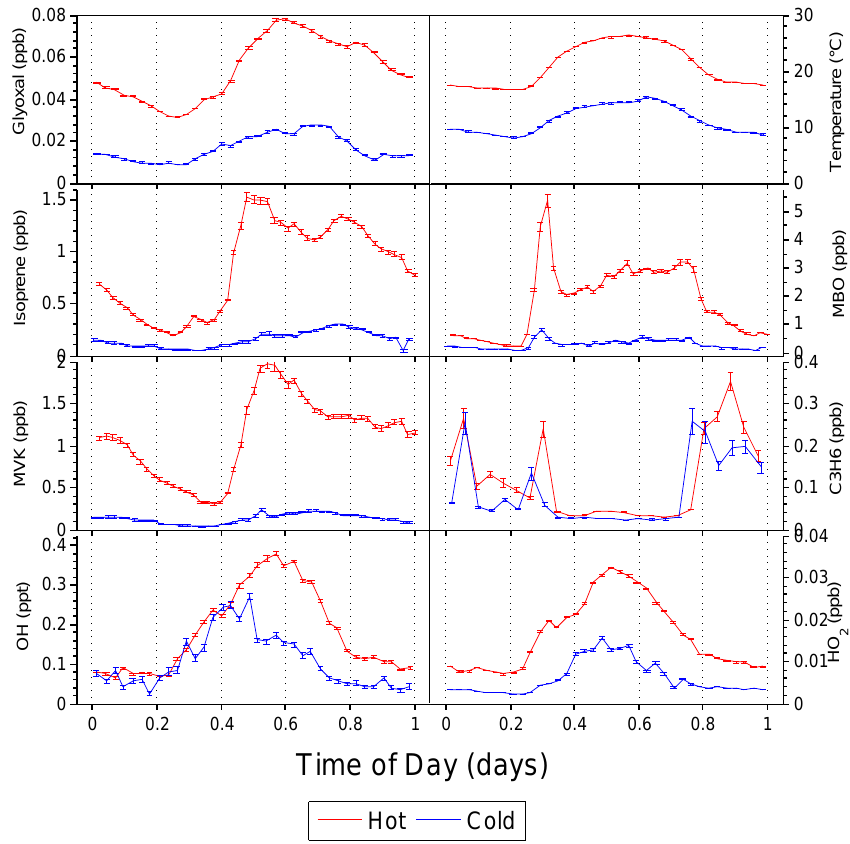
Fig. 2. Diurnal averages of glyoxal, temperature, example biogenic and anthropogenic species, and HO x separated into hot and cold period. Here the hot period spans 15 days. The cold period contains only data for which glyoxal was recorded. Error bars indicate the 1 standard deviation envelope as calculated based on the variability in the data from day to day and neglecting reported or calculated error from each measurement.